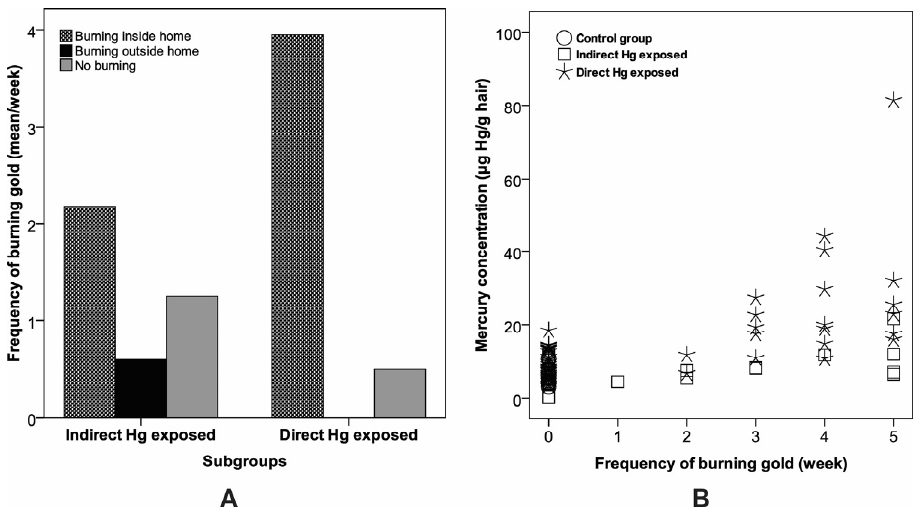
Figure 5. The route of exposure ( A ) burning area of gold have significant differences in each group of samples. ( B ) Frequency of contact with gold burning has a significant correlation with mercury